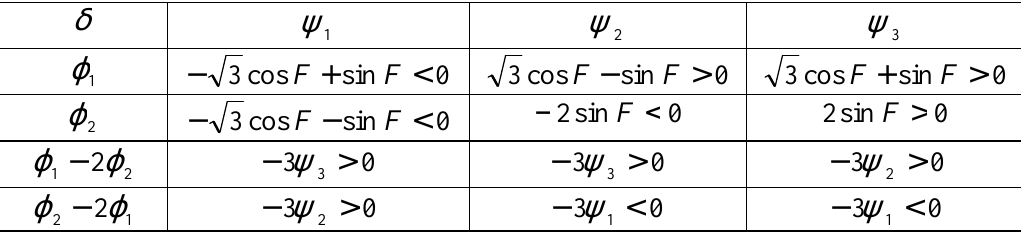
Table 1. Important expressions for all three values of d